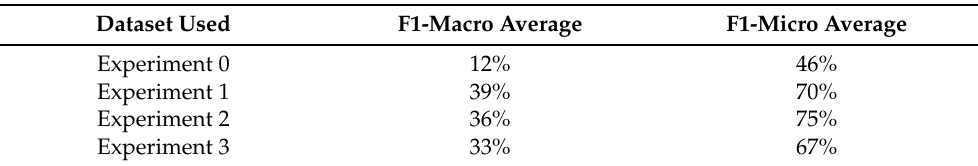
Table 3. Macro and micro average F-1 scores for the experimental evaluation obtained at the first classification stage.